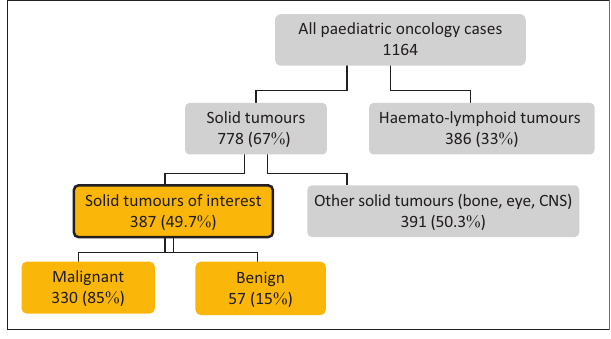
FIGURE 1: All tumours seen over a 10-year